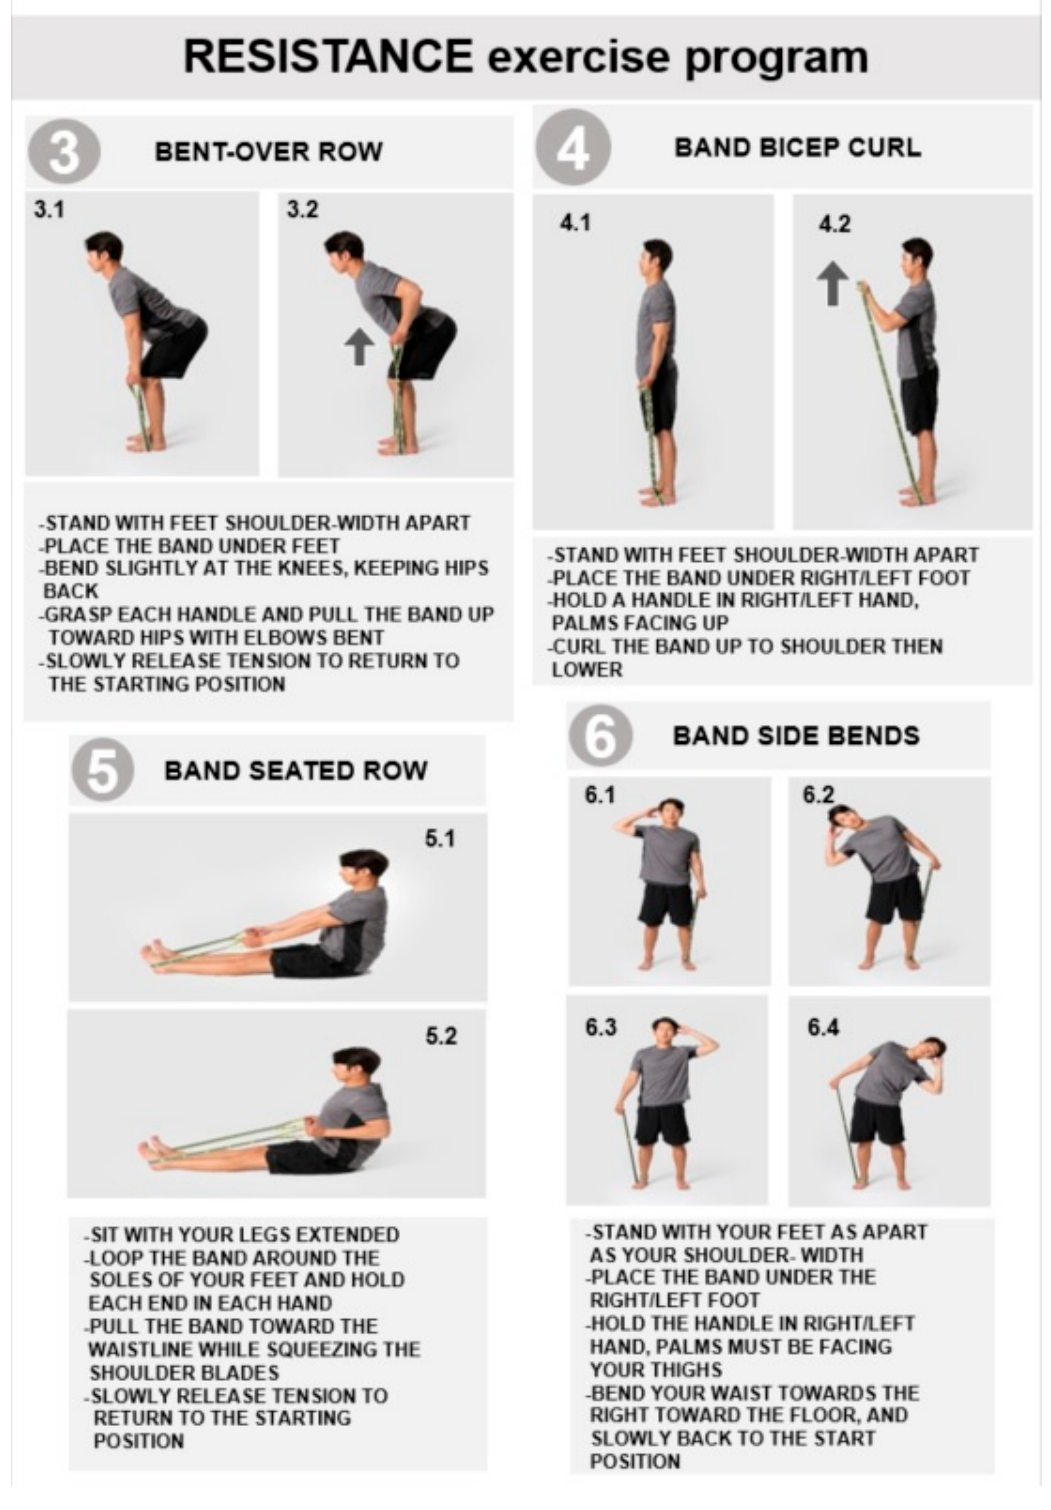
Figure A14. Detailed description and components of each movement in the “Band routine part 2” resistance exercise.